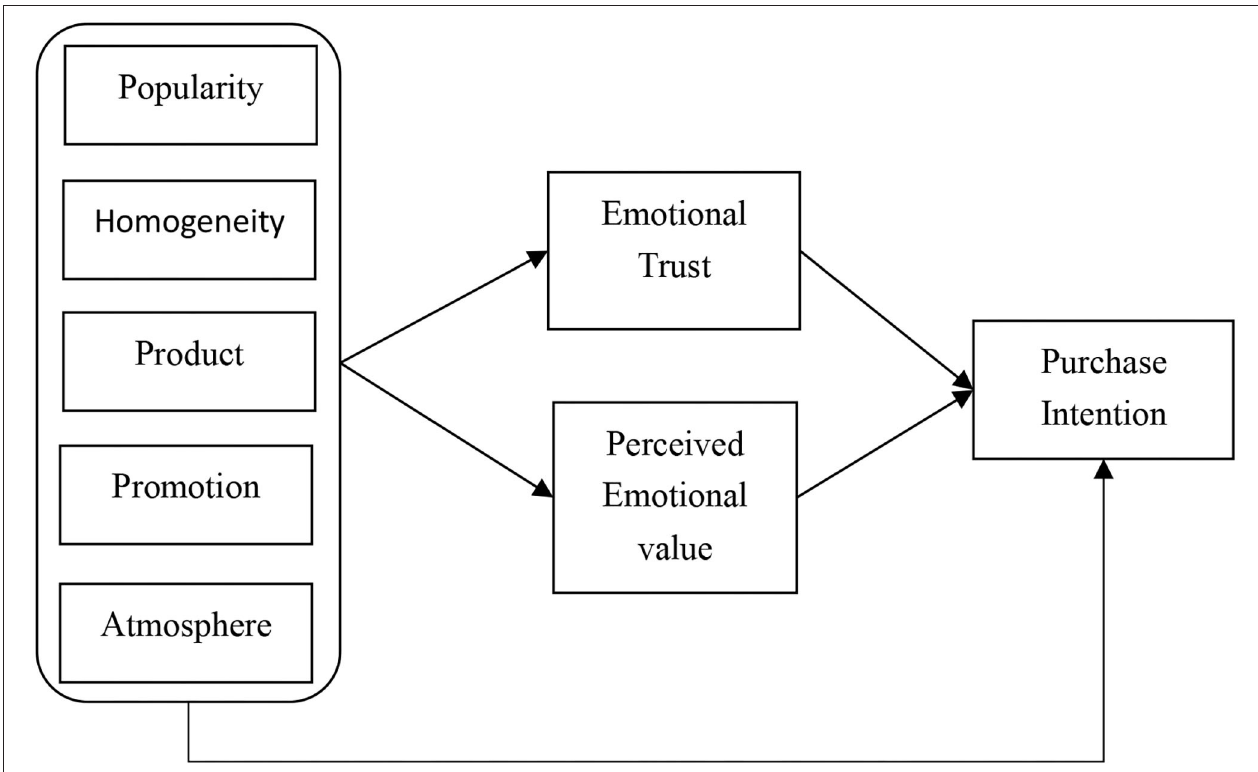
FIGURE 1 | Conceptual